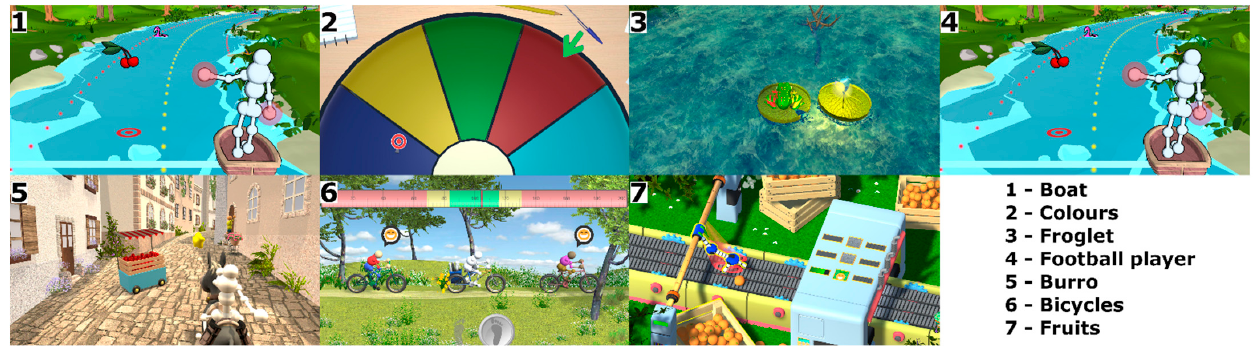
Figure 2. Games implemented in the virtual reality environment.